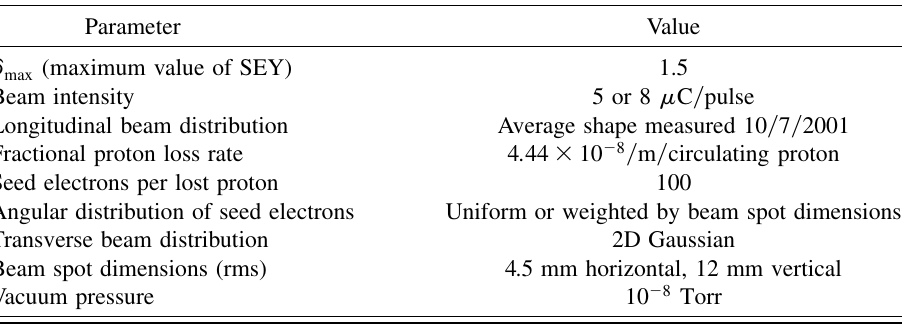
TABLE II. Parameters used in the